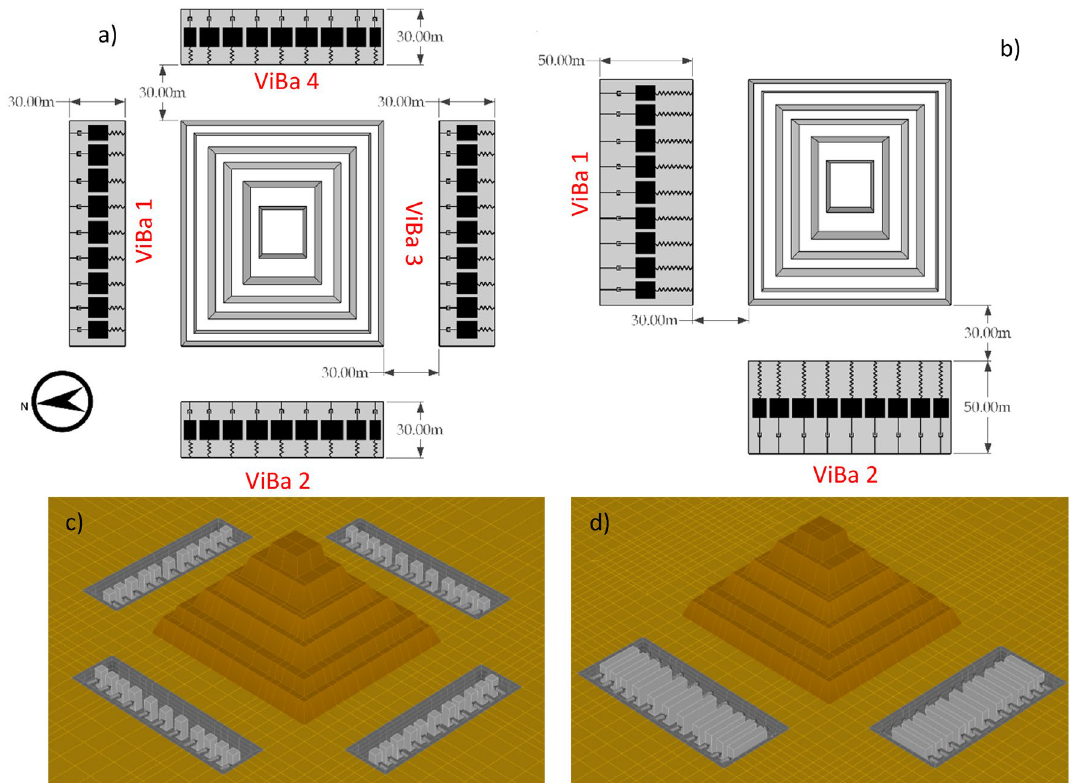
Figure 3. ViBa configurations for Case 1 in panels ( a ) and ( c ) and Case 2 in panels ( b ) and ( d ). Each excavation can include several units that can act asynchronously (with different mechanical properties) or synchronously (identical mechanical properties) according to the specific design. ViBa protects the Pyramid by exploiting the soil-structure interaction phenomenon and not by filtering the seismic waves; therefore, the two configurations will be both effective regardless the direction of the seismic